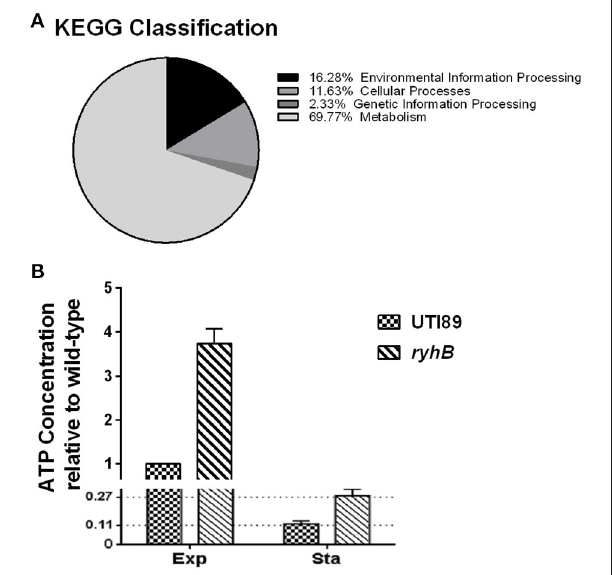
FIGURE 7 | The ryhB -knockout mutant causes bacterial transition to a hyperactive metabolic state. (A) KEGG classification of upregulated genes in the ryhB -knockout mutant. Stationary phase bacteria (cultured for 10h, ∼ 10 9 CFU/mL) were used for RNA-Seq analysis. (B) Relative ATP concentration in the parent strain UTI89 and the ryhB -knockout mutant at the exponential (Exp, cultured for 3h, ∼ 10 8 CFU/mL) and stationary phases (Sta, cultured for 10h, ∼ 10 9 CFU/mL). ATP concentration of the parent strain during the exponential phase was considered as 1 unit. Error bars show standard variations ( n = 3).